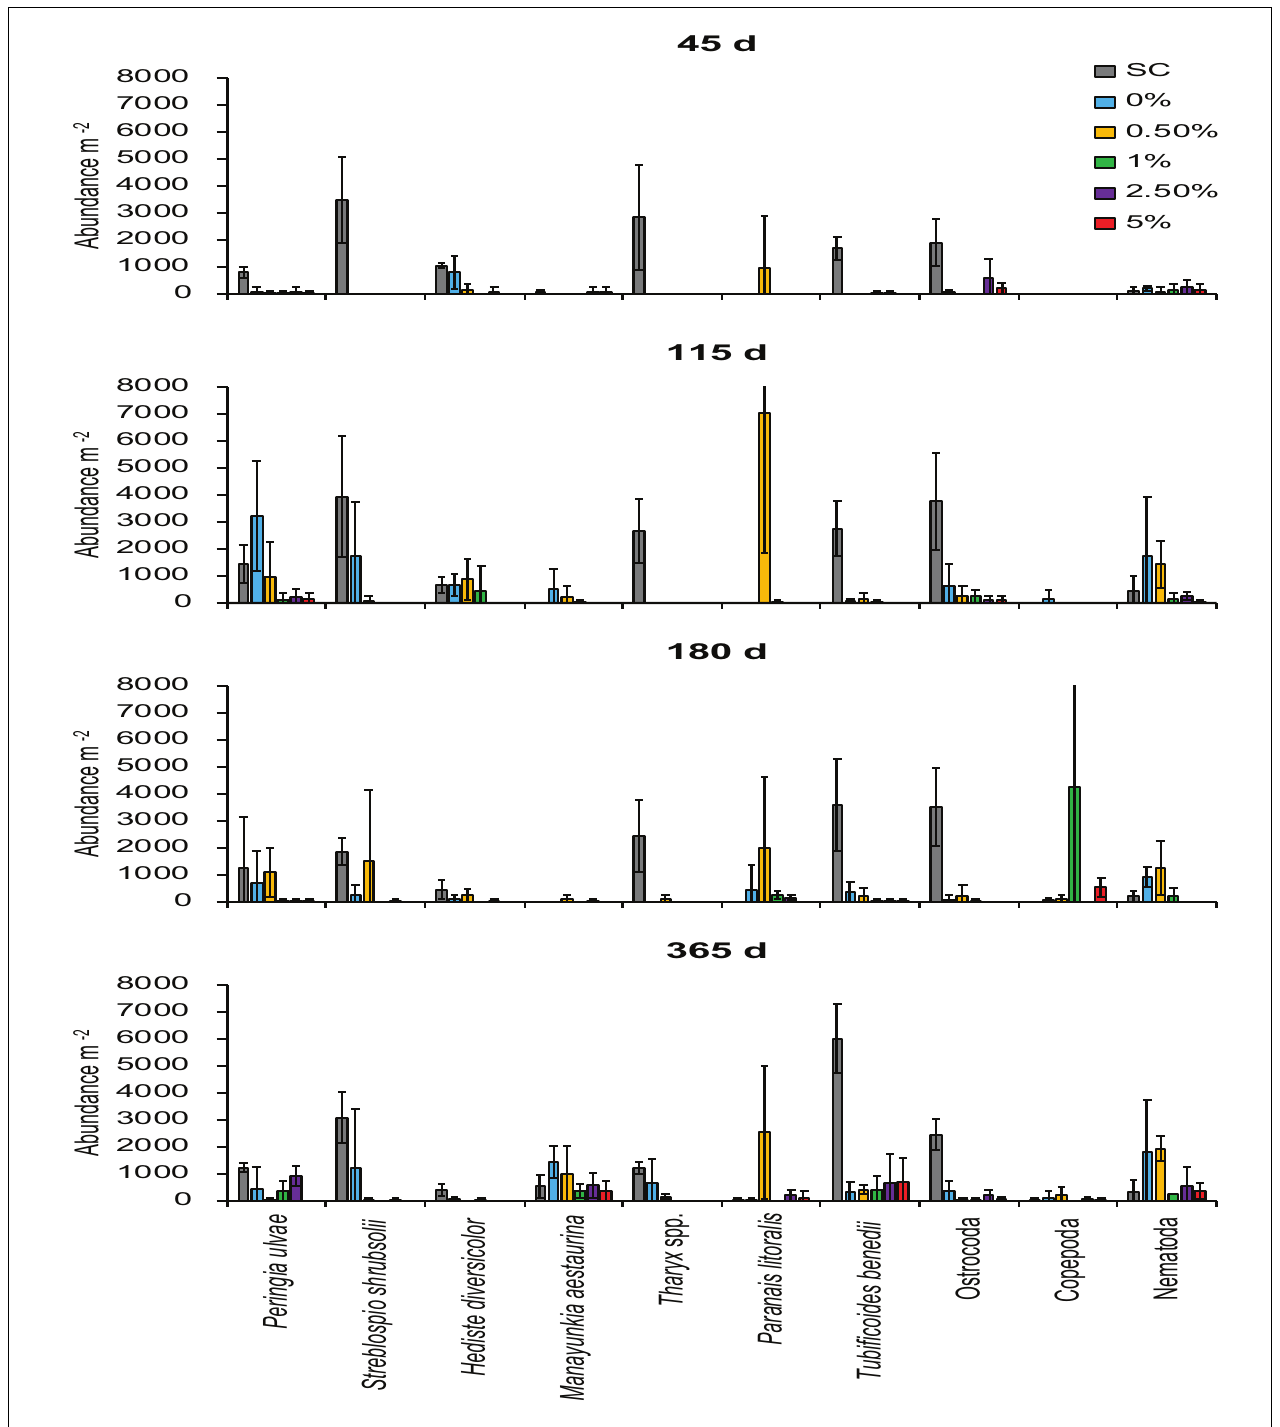
FIGURE 7 | Mean abundance (per m 2 ) of the 10 most abundant taxa in the different treatments over time. Errors bars denote ± 95% confidence intervals ( n = 3). Colors used for the different treatments are the same as used in Figure 2 to aid clarity.